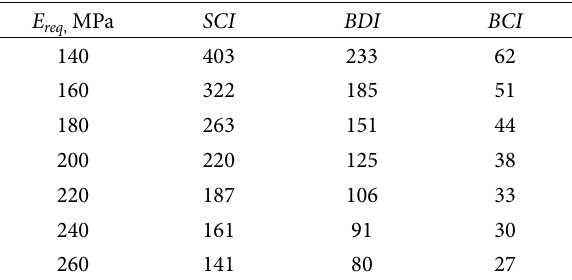
Table 6. DBPs limit values for E req , AC pavement on top of existing pavement